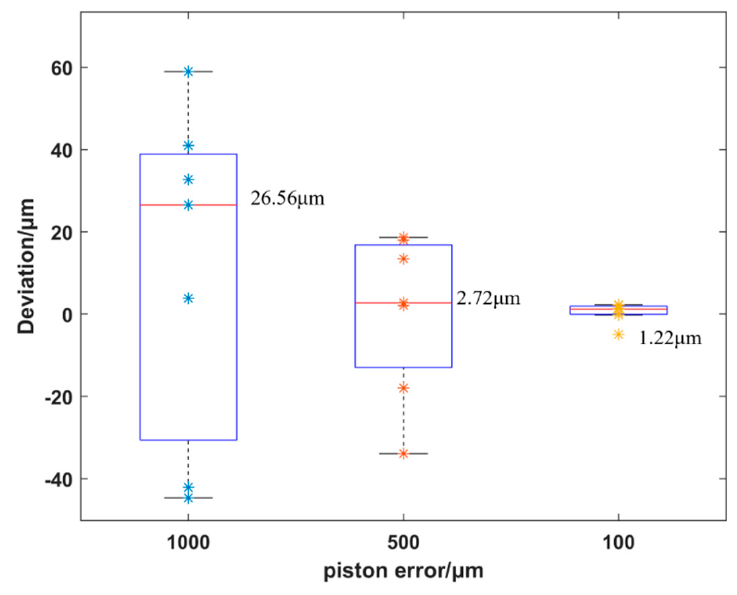
Figure 10. Boxplot of the deviations of the measurement results (coarse phasing).